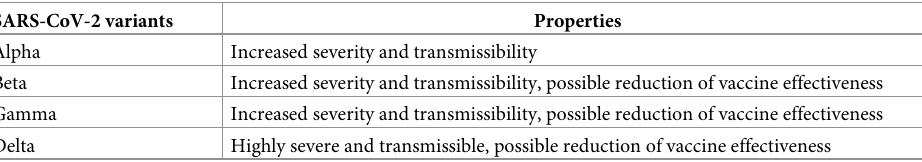
Table 1. SARS-CoV-2